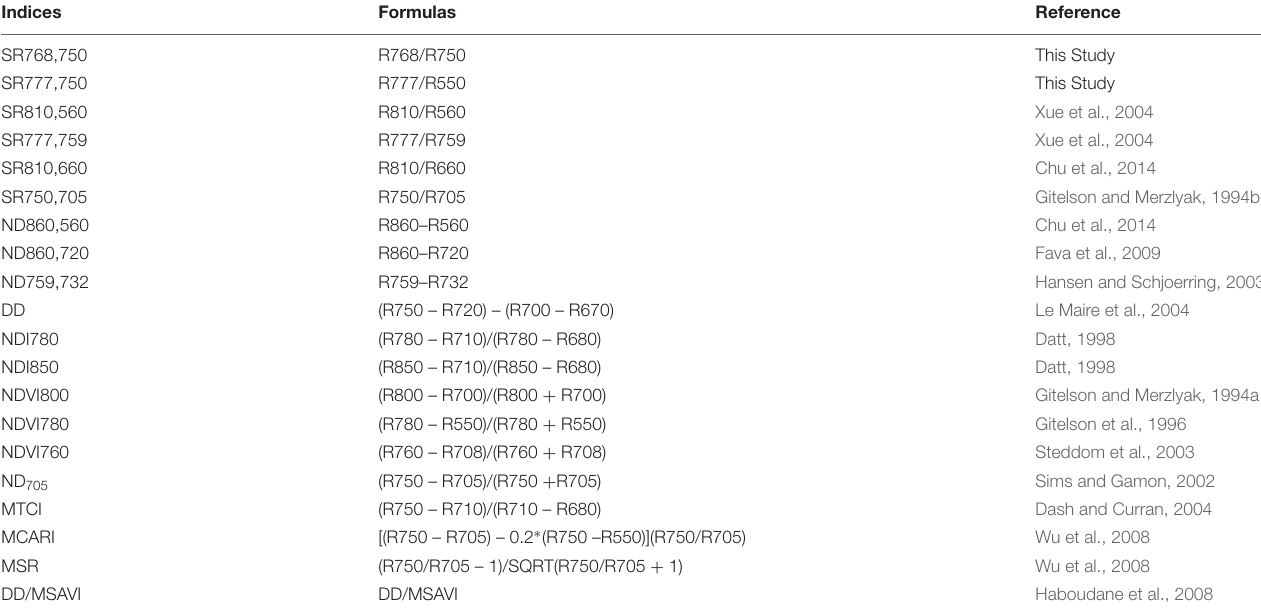
TABLE 2 | Descriptions and formulas of vegetation indices investigated for leaf nitrogen status indictor (LDW, LNC, and LNA) during 2015 and